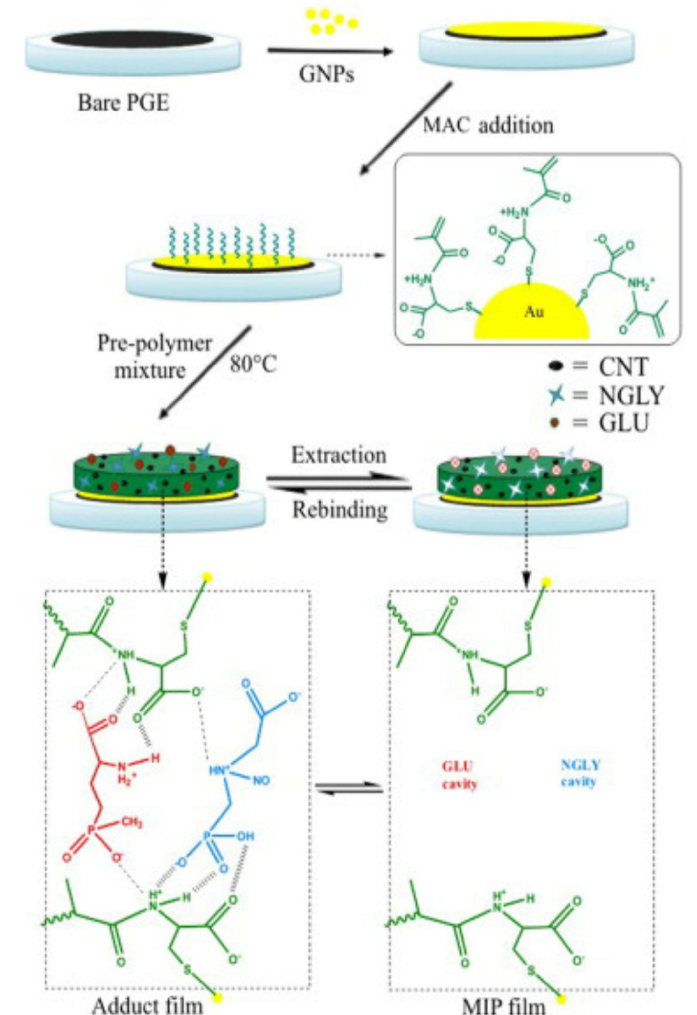
Figure 26. Schematic representation of double-template imprinted polymer-modified GNPs-PGE fabrication and the suggested binding mechanism for simultaneous analysis of GLYP and GLU in their respective MIP cavities. Reprinted with permission from [206]. Copyright 2014 Elsevier.